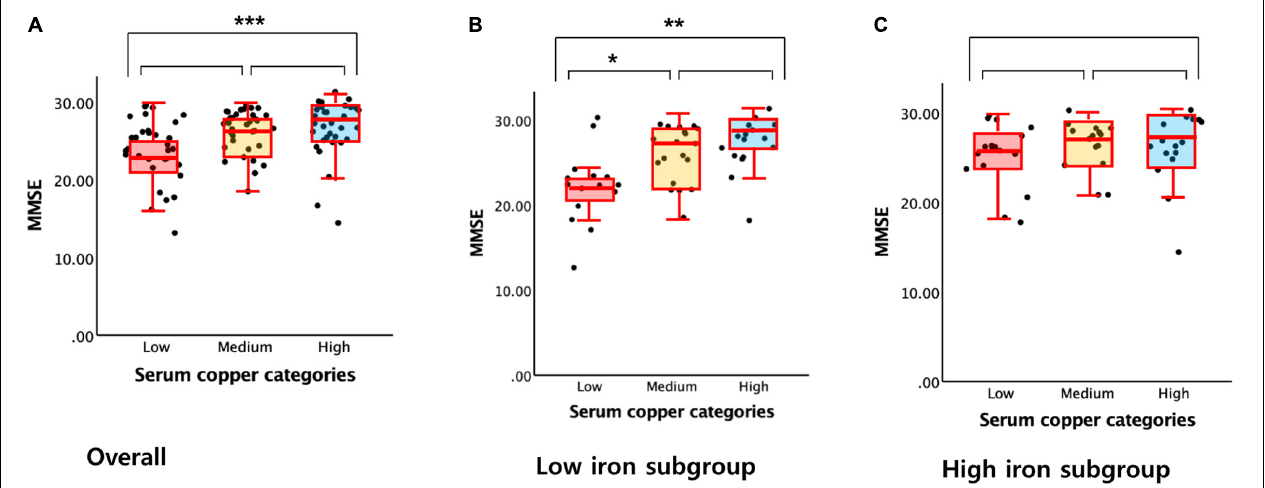
FIGURE 2 | Box plots of the serum copper categories and MMSE score. (A) Overall and (B,C) by subgroup ( B , low iron and C , high iron). Multiple linear regression analyses were performed after adjusting for all confounders. * P < 0.05; ** P < 0.01; *** P < 0.001.